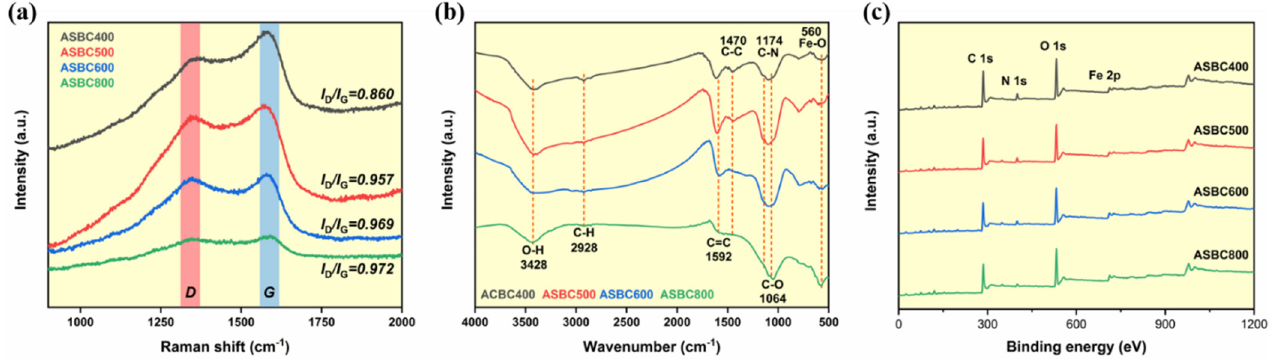
Figure 3. Raman spectra ( a ), FTIR spectra ( b ), and XPS spectra ( c ) of ASBCx.